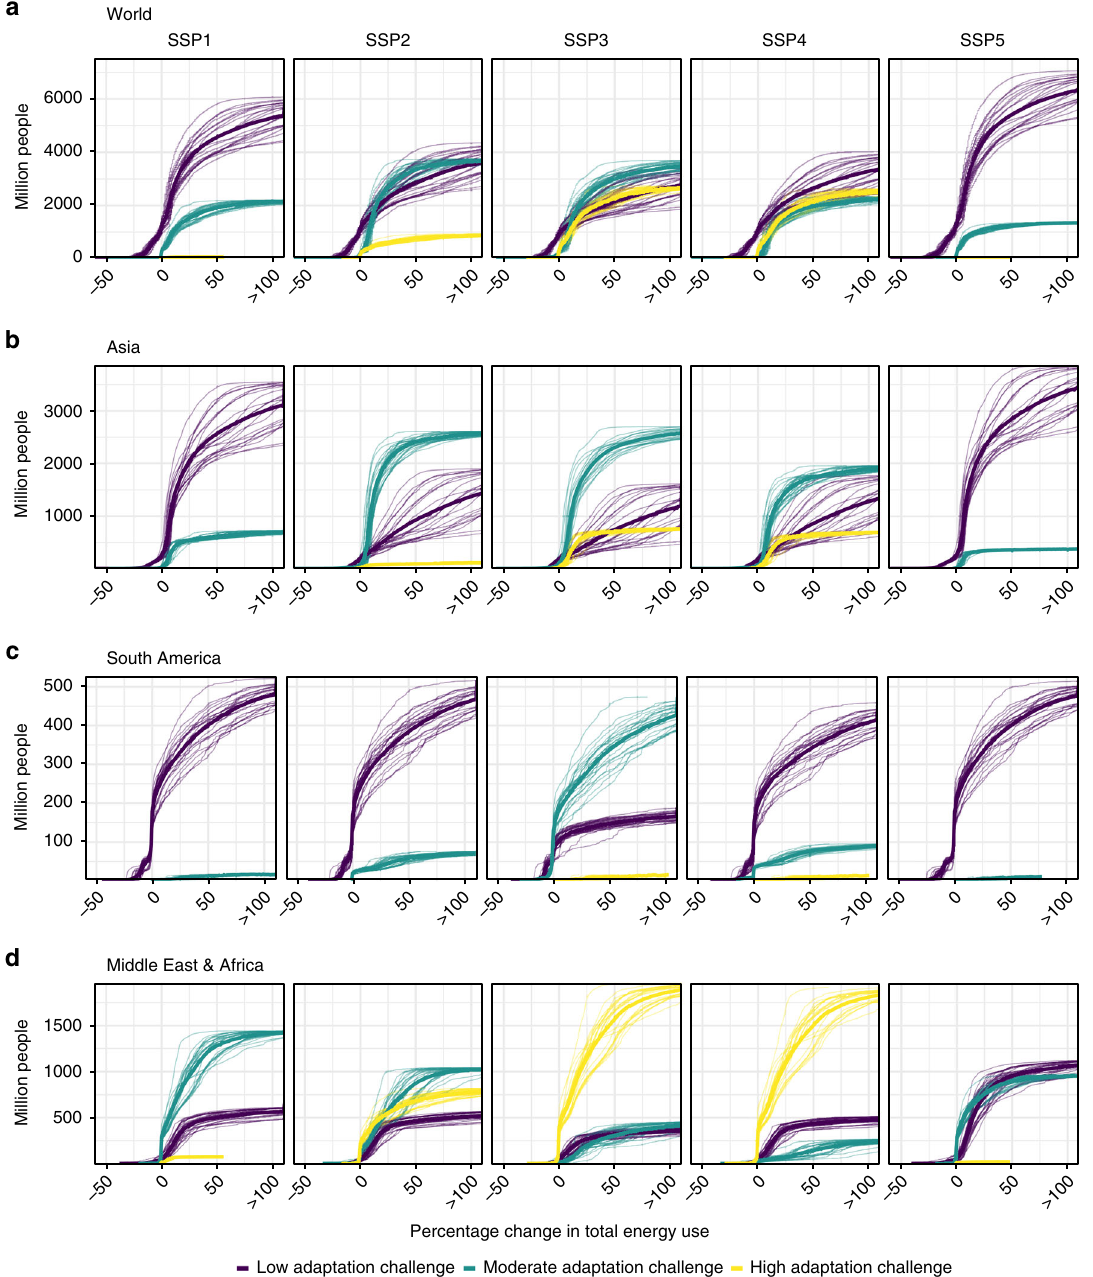
Fig. 5 Exposure of people with different adaptation challenges to changes in energy demand. Cumulative distribution of the number of people exposed to percentage change in climate-related fi nal energy demand by country GDP per capita. Panels represent global results ( a ) and three major developing world regions: Asia ( b ), South America ( c ), and Middle East and Africa ( d ). Lines indicate the multi-model mean and all individual 21 CMIP5 models by